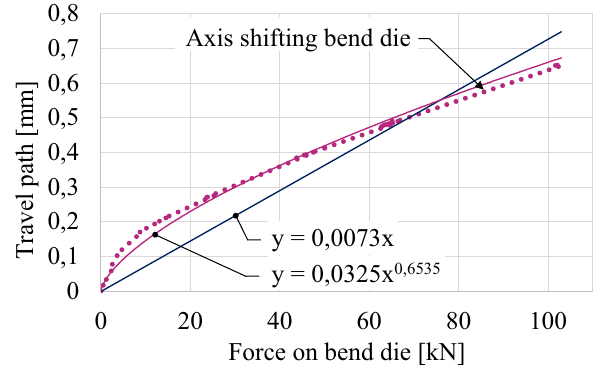
Fig. 17 Axis shifting of the bend die